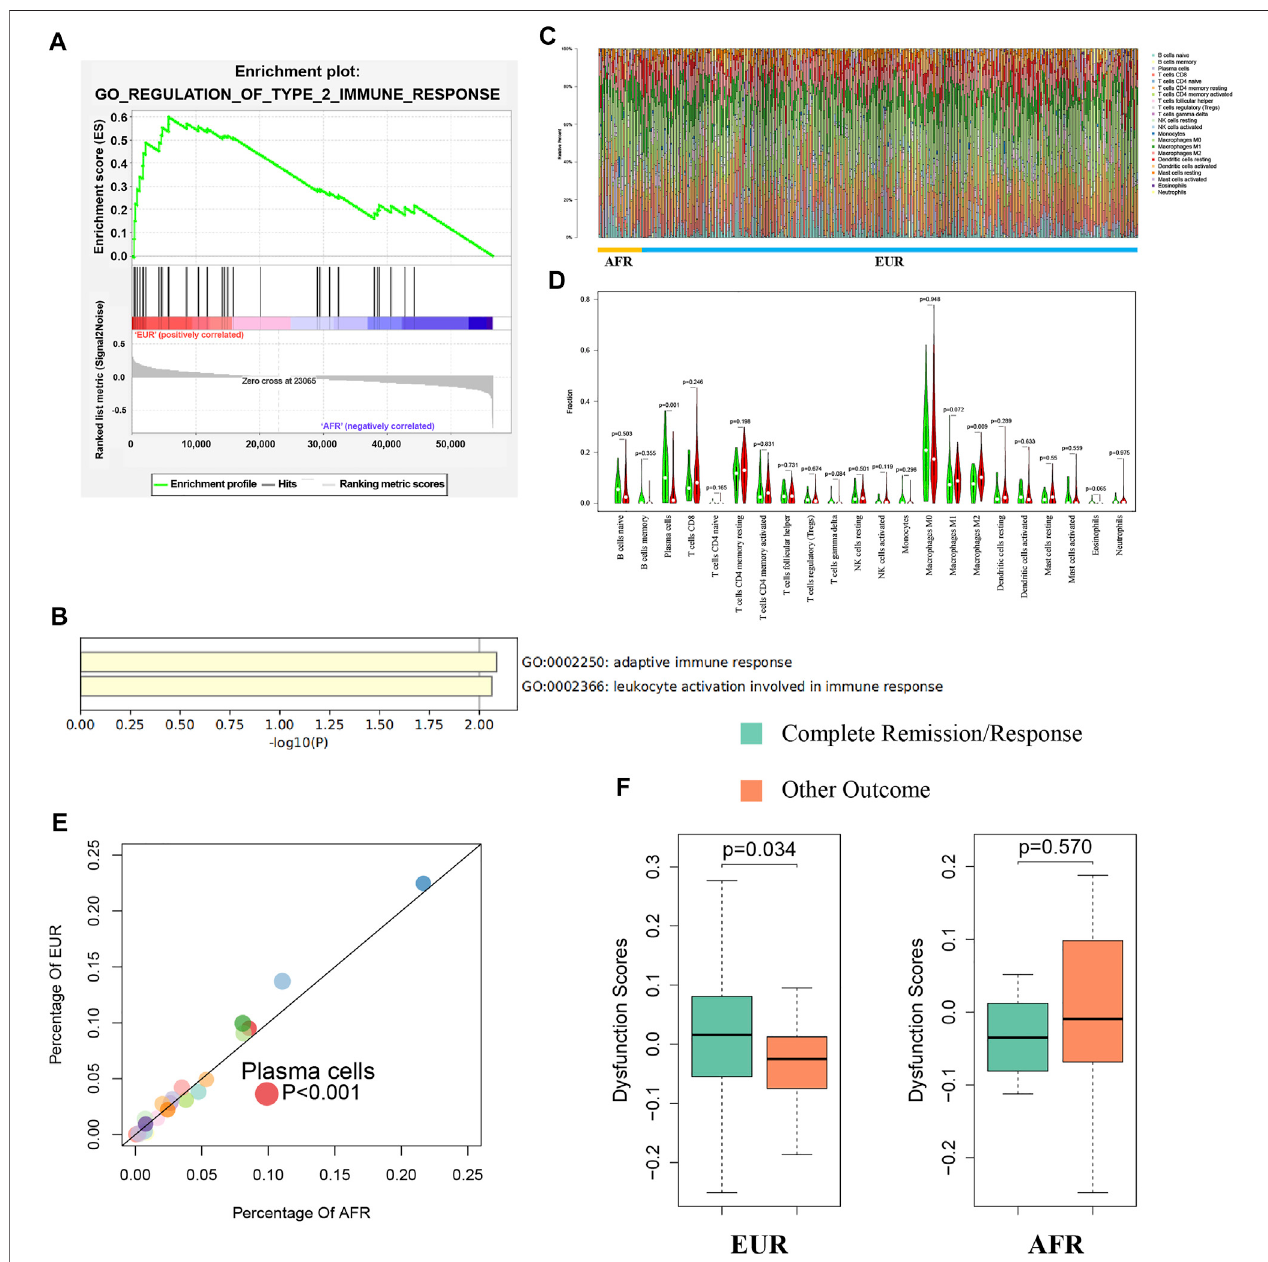
FIGURE 7 | Differences in immunity between EUR and AFR OSCC patients. (A) GSEA of differentially expressed genes between EUR and AFR ancestries in the GO_REGULATION_OF_TYPE_2_IMMUNE_RESPONSE pathway. (B) Enrichment analysis of genes used to build the ceRNA risk regression model using Metascape showedthatthesegeneswereassociatedwiththeimmuneresponse. (C) Histogramofthedegreeofin fi ltrationofdifferentimmunecelltypesinEURandAFRancestries. (D) Violin plot of the differences in the degree of in fi ltration ofdifferent immune cell types between EUR and AFR ancestries. (E) Scatter plot of the differences in the degree of in fi ltration of different immune cell types between EUR and AFR ancestries. (F) Relationships between T cell dysfunction scores and preliminary treatment outcomes in EUR and AFR OSCC patients.